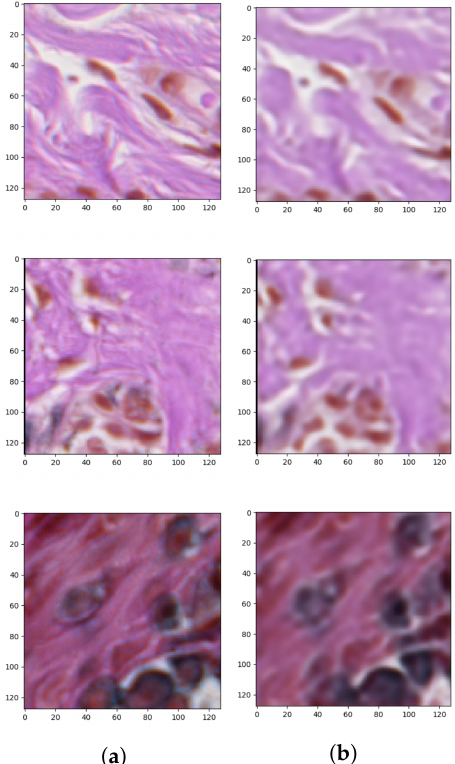
Figure 7. Outcomes of the first stage of autoencoder semi-supervised training process showing: ( a ) original patches and ( b ) reconstructed